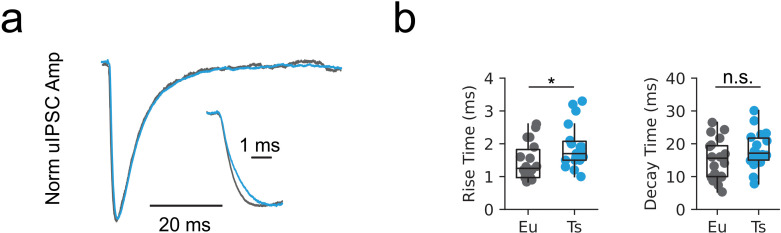
Abnormal IPSC kinetics in DS.(a) Representative unitary inhibitory synaptic currents recorded at the MC to PN synapse. Inset: detail of the rise phase. (b) Population data of the rise time (left, p=0.02448, Mann-Whitney U test) and decay time (right, p=0.1488, Mann-Whitney U test, n = 18 and 18 for Eu and Ts, respectively).Figure 1—figure supplement 2—source data 1.MC to PN synapse kinetics.